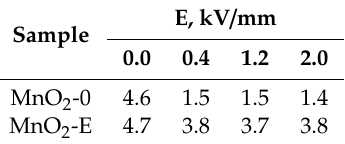
Table 2. The values of η (cid:48) p in MnO 2 -0 and MnO 2 -E elastomers as a function of the electric field strength. E, kV / Sample